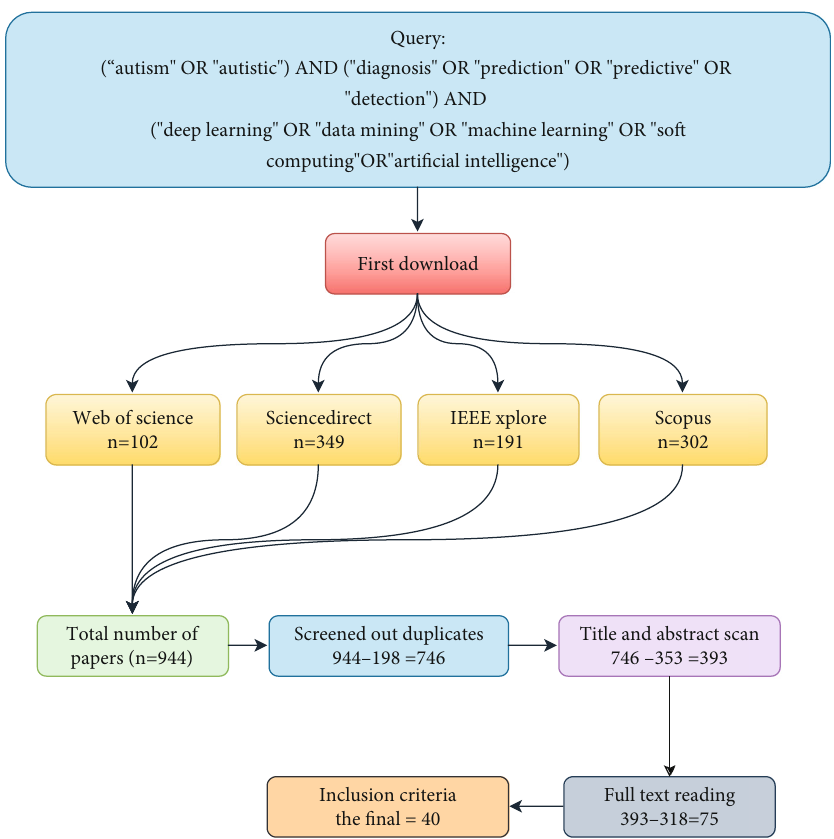
Figure 1: Study selection fl owchart including the search queries and inclusion criteria.